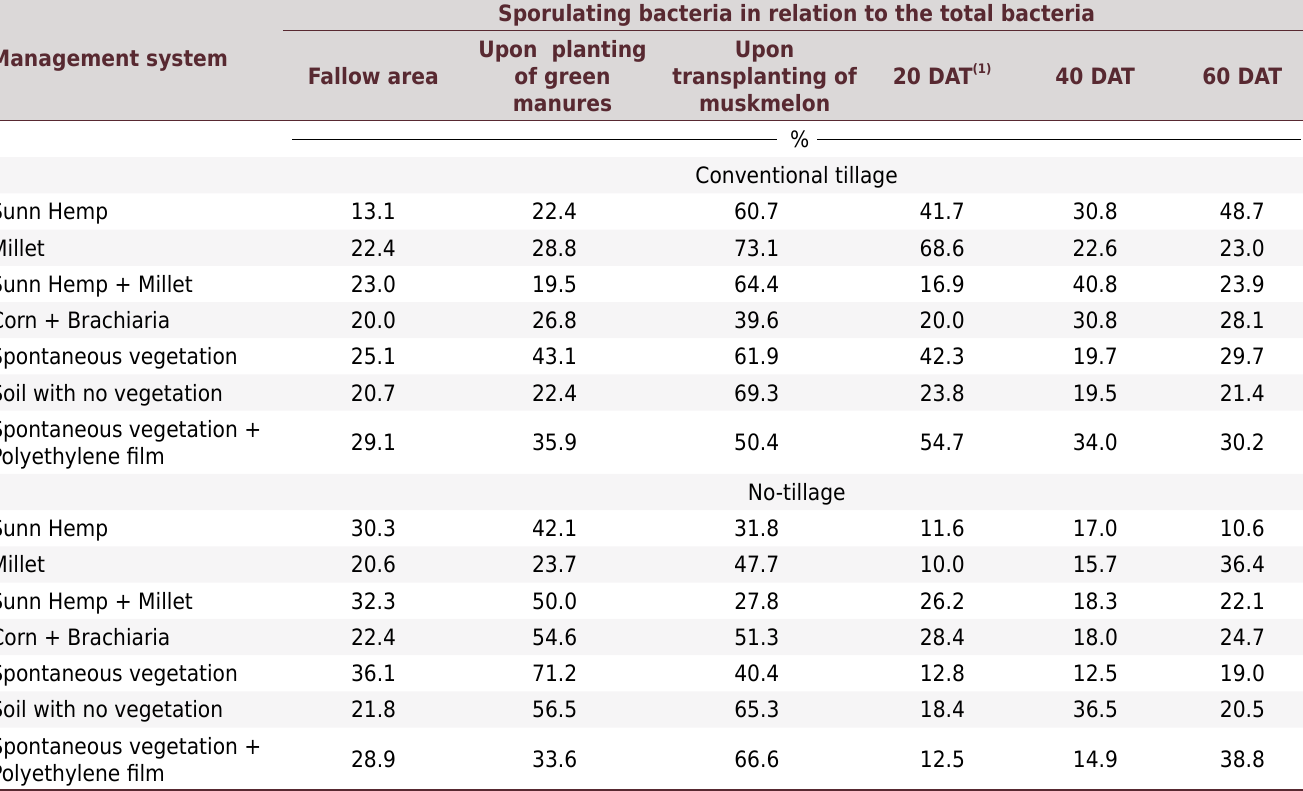
Table 3. Sporulating bacteria in relation to total bacteria in the no-tillage and in the conventional tillage systems in different management systems and soil sampling times. Sporulating bacteria in relation to the total bacteria Upon planting Management system Fallow area of green